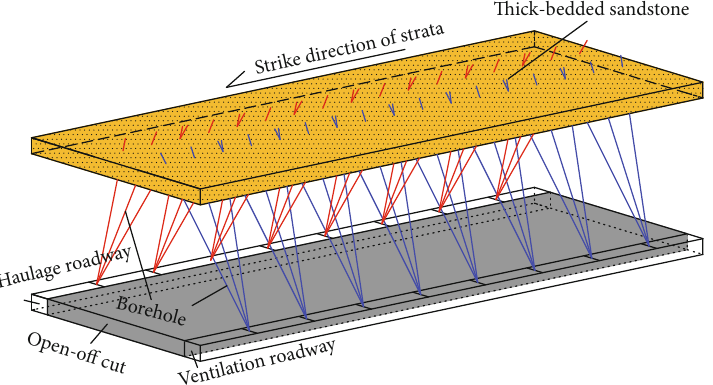
Figure 6: Layout of the diversion drilling holes.